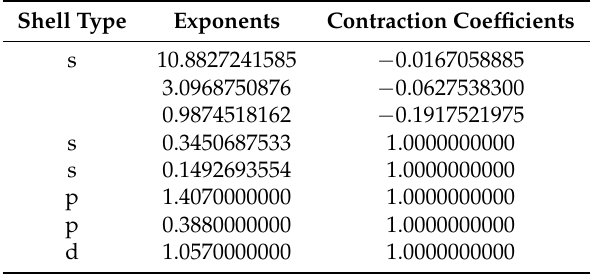
Table A5. Parameters of the cc-TZVP basis set of Hydrogen. Parameters taken from [80].